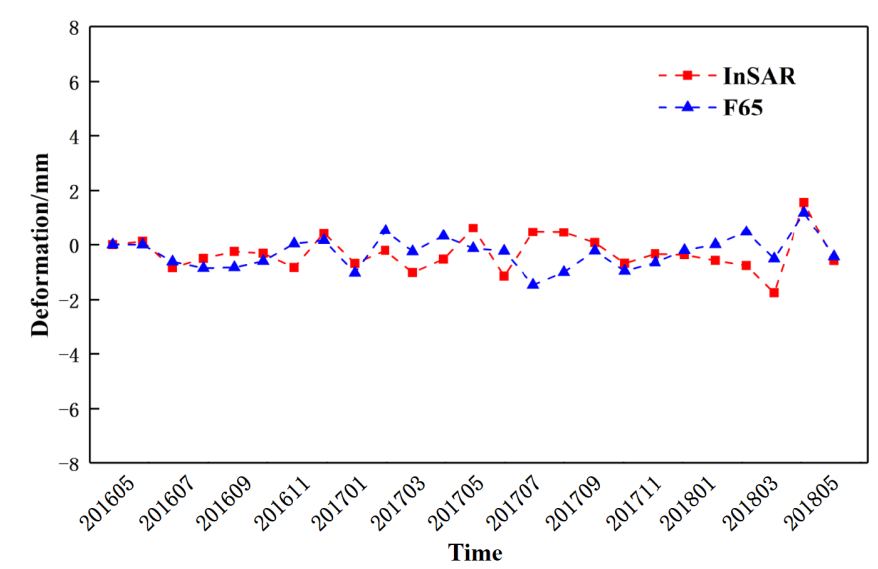
Figure 7. The time series relationship between the leveling observation data F65 and the PSInSAR result at groundwater monitoring well W65.